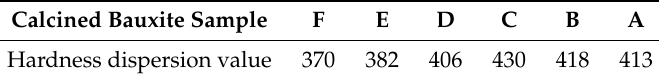
Table 3. Hardness dispersion of calcined bauxite (GPa).